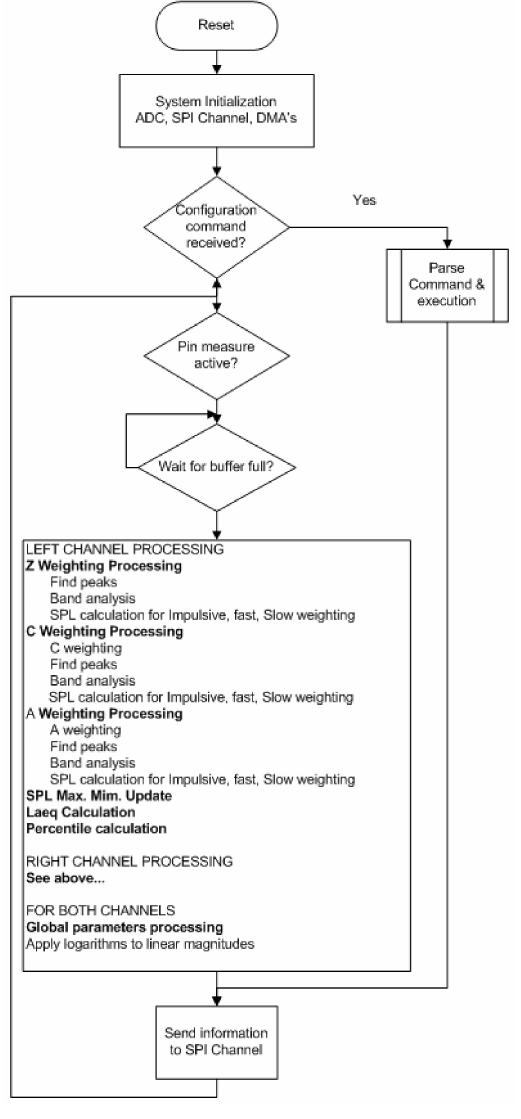
Figure 5. Software